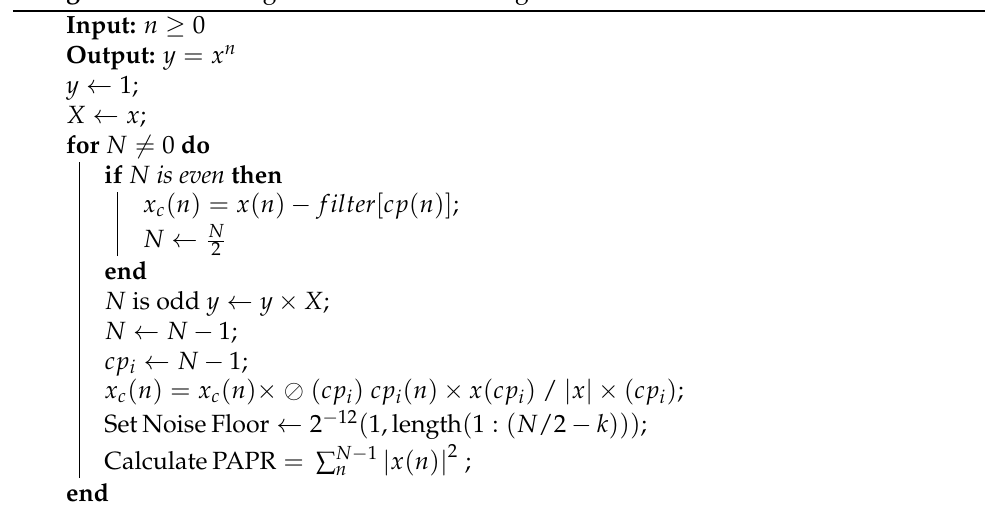
Algorithm 1: CFR algorithm with PAPR target.